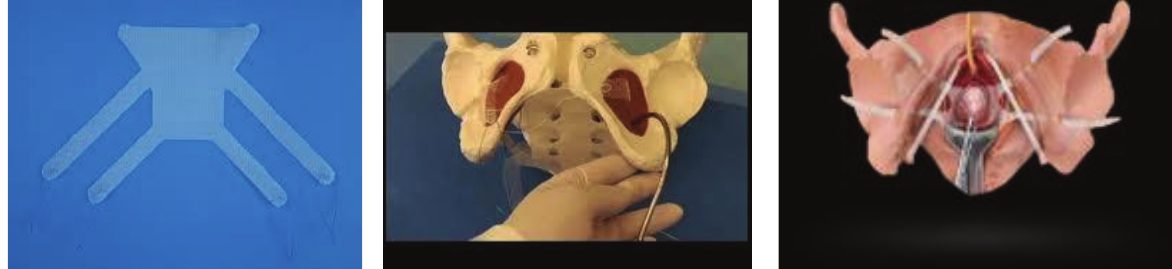
Figure 2: The posterior part of the four-arm mesh was passed through the obturator foramen.